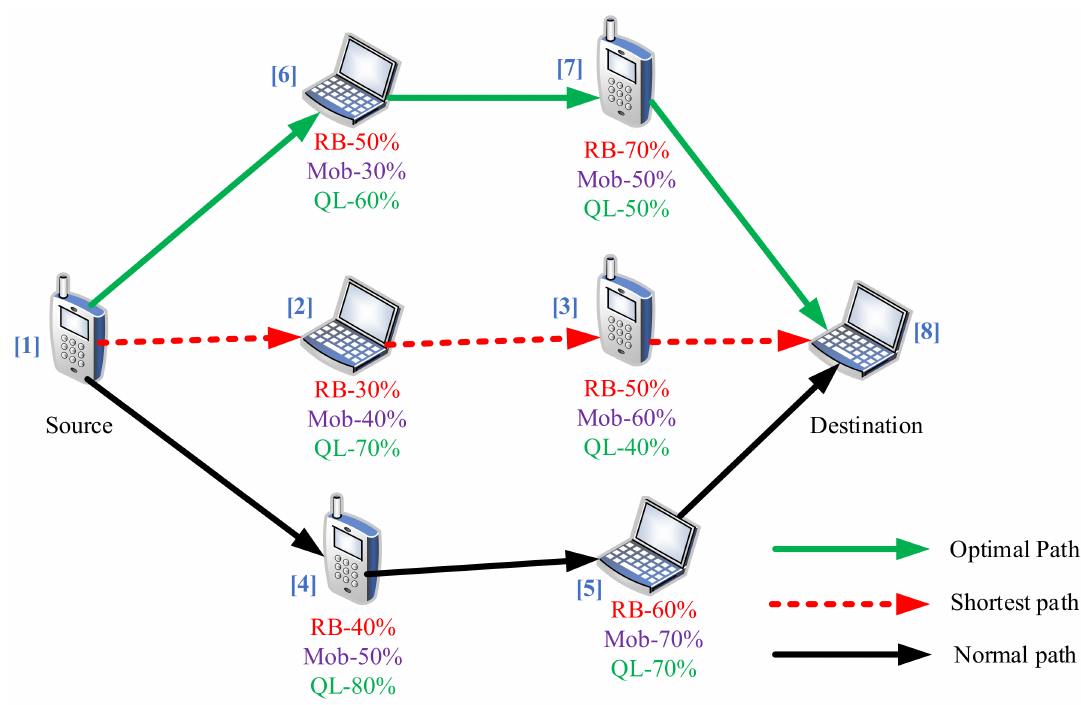
Figure 3. A general network scenario to validate and verify the MBMQA routing